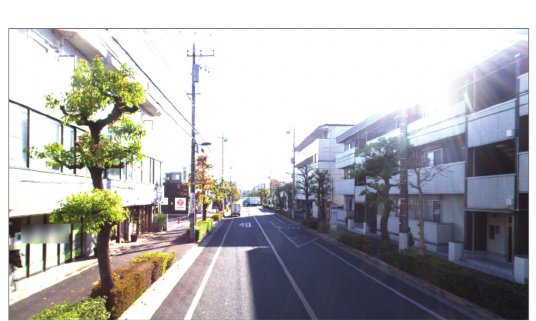
Figure 10 . Landscape of the evaluation